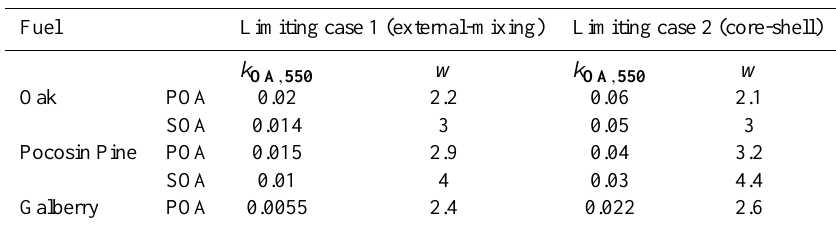
Fig. 5. Measurement-constrained absorption coefficients (black diamonds), and model calculations using different assumptions on OA ab- sorptivity (solid lines) for (a) fresh oak emissions and assuming external-mixing (limiting case 1), (b) aged oak emissions and assuming external-mixing (limiting case 1), (c) fresh oak emissions and assuming core-shell morphology (limiting case 2), and (d) aged oak emissions and assuming core-shell morphology (limiting case 2). See Sect. 3.4 for description of calculations associated with each curve. The same data are plotted on a log-log scale in Fig. S4. Table 1. Imaginary part of the refractive indices of the organics in the investigated fuels at 550nm and their wavelength dependence ( k OA = k OA , 550 (550 / λ) w ) . The uncertainty in k OA values is approximately ±